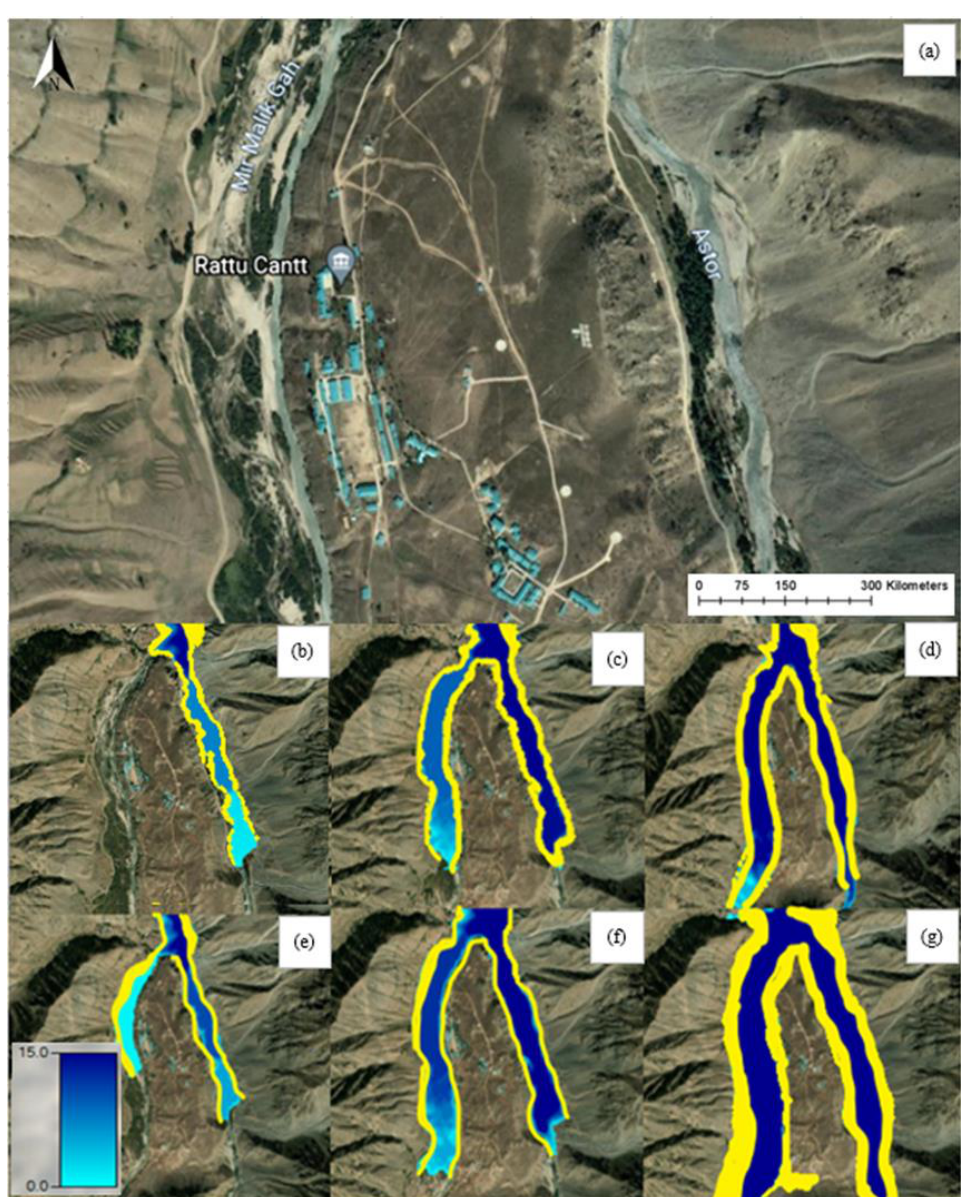
Figure 7. ( a ) Astore river reach showing the affected area before mapping. Flood mapping of Astore river under ( b ) mid-century 2.6, ( c ) mid-century 4.5, ( d ) mid-century 8.5, and ( e ) late-century 2.6, ( f ) late-century 4.5, ( g ) late-century 8.5, RCP scenarios. The yellow color in the Figures represents the regions/settlements affected by the